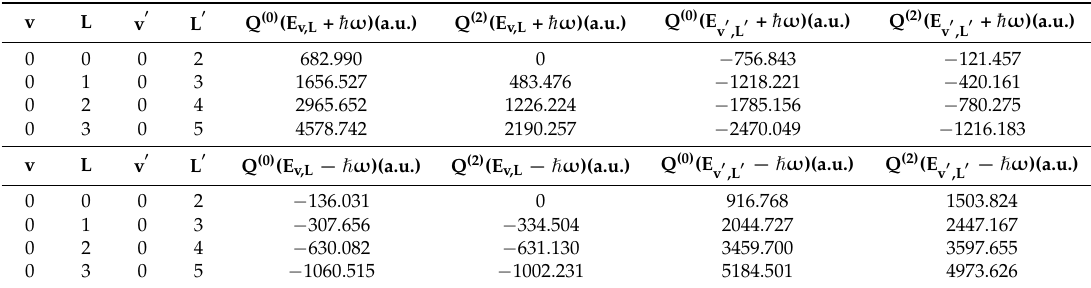
Table 2. Reduced matrix elements of the two-photon operator Q (k) (E vL ± (cid:125) ω ) for the transitions